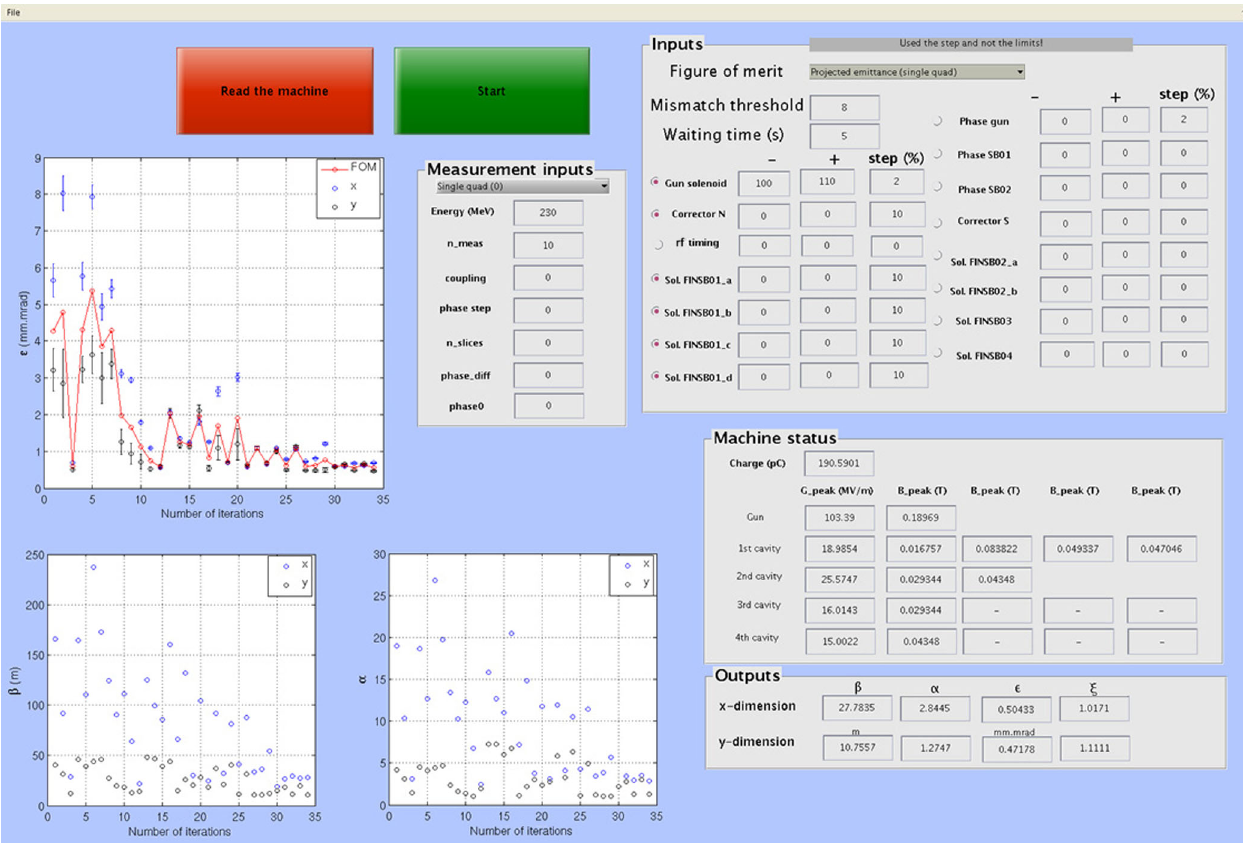
FIG. 16. GUI for the emittance optimization in the